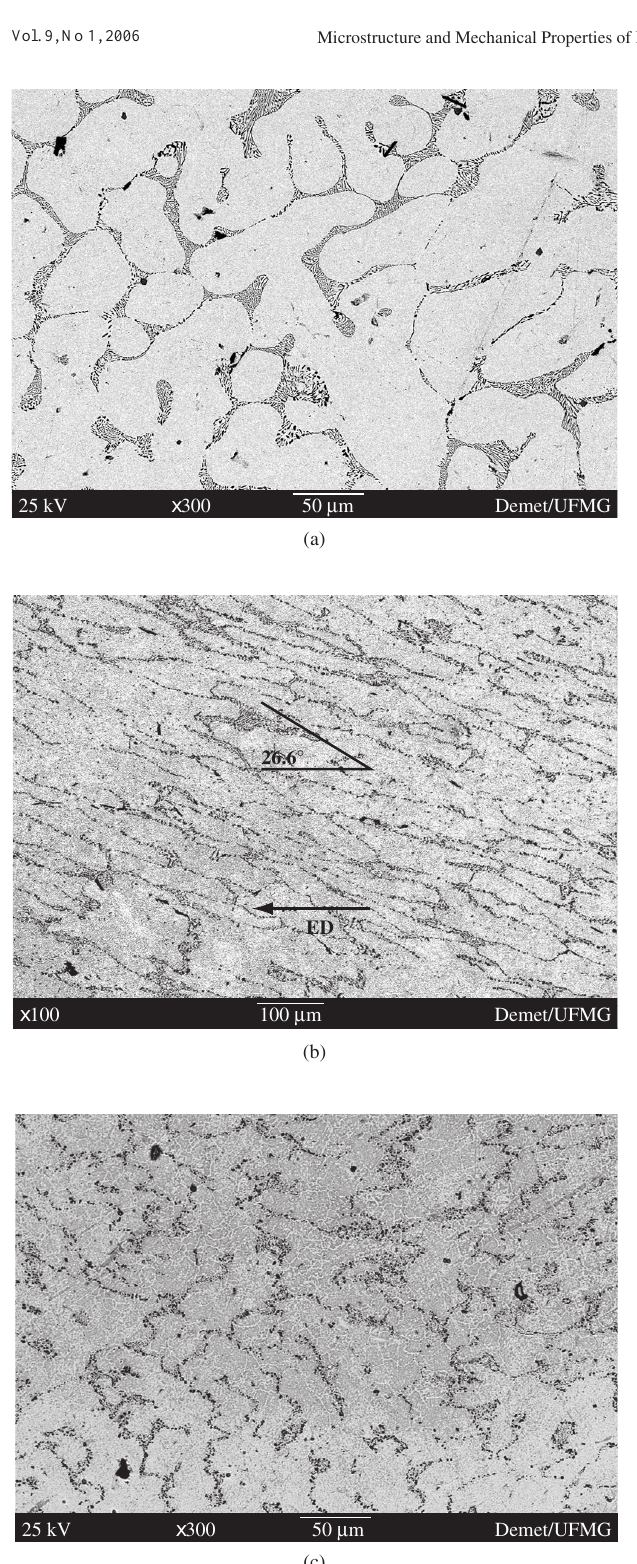
Figure 3. Microstructure of a) As-cast alloy; b) Longitudinal section of the alloy processed by 1 pass; and c) Longitudinal section of the alloy processed by 2 passes of ECAP.